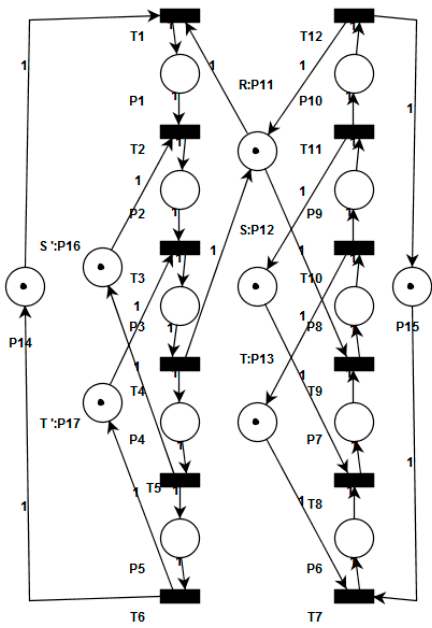
Figure 5. Modified BORPN net with virtual resources.